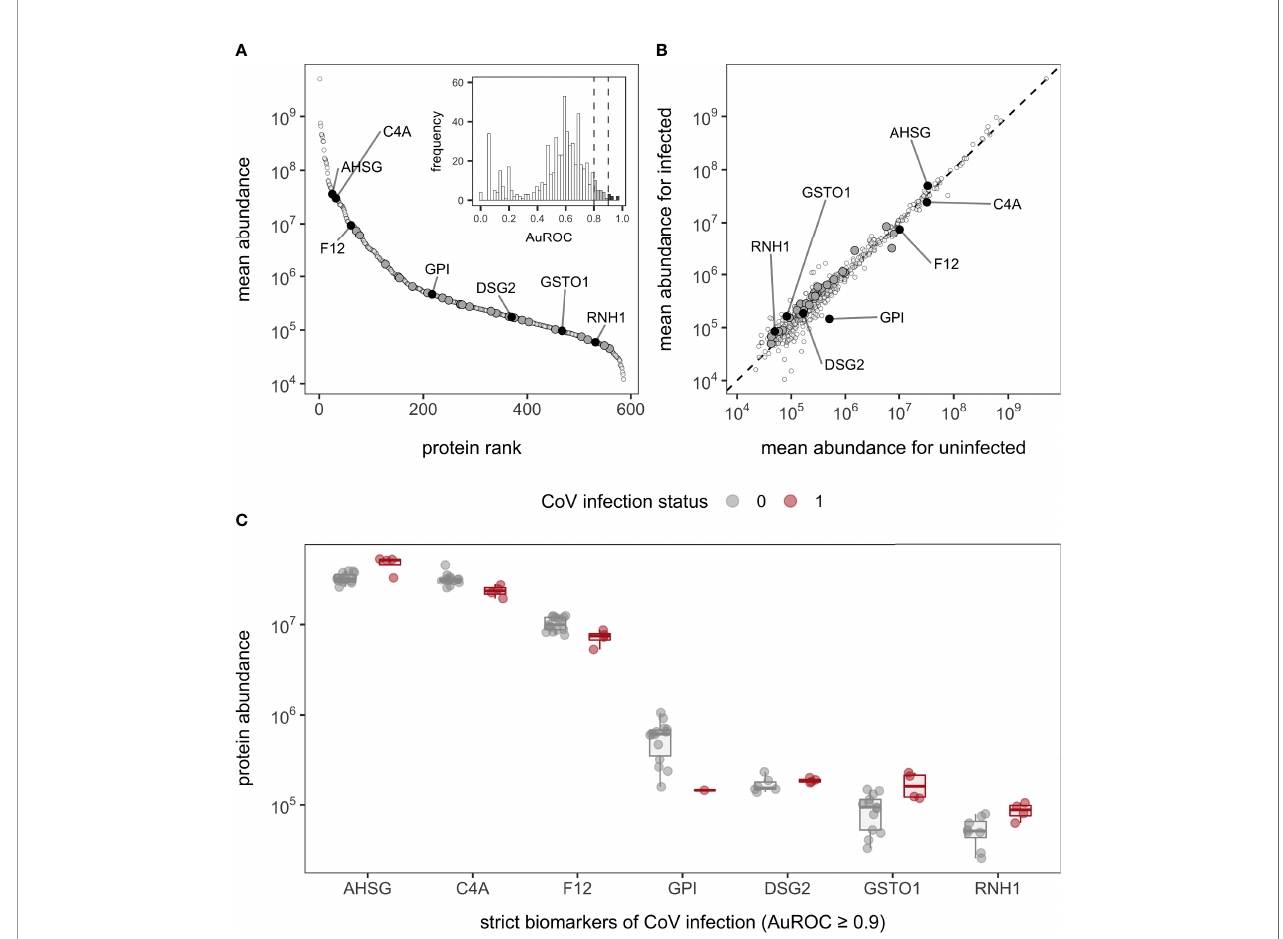
FIGURE 2 | Serum protein abundance and biomarkers of CoV infection in vampire bats. (A) Mean abundance of the 586 proteins was plotted with corresponding rank to illustrate the dynamic range of the serum proteome. The inset displays the distribution of AuROC values for protein biomarkers of CoV infection alongside cutoffs of 0.8 and 0.9 for strict and less-conservative biomarkers. (B) Comparison of mean protein abundance for uninfected and infected bats across all proteins; the dashed line shows the 1:1 reference. For both plots, less-conservative and strict biomarkers are shown in dark gray and black, with the latter labeled with gene symbols (AHSG, alpha-2-HS-glycoprotein; C4A, complement C4A; F12, coagulation factor XII; GPI, glucose-6-phosphate isomerase; DSG2, desmoglein-2; GSTO1, glutathione S-transferase omega-1; RNH1, ribonuclease inhibitor). Missing values were excluded prior to determining mean abundances. (C) Protein abundance between uninfected and infected bats for strict biomarkers of CoV positivity; boxplots are overlaid by raw data jittered to reduce